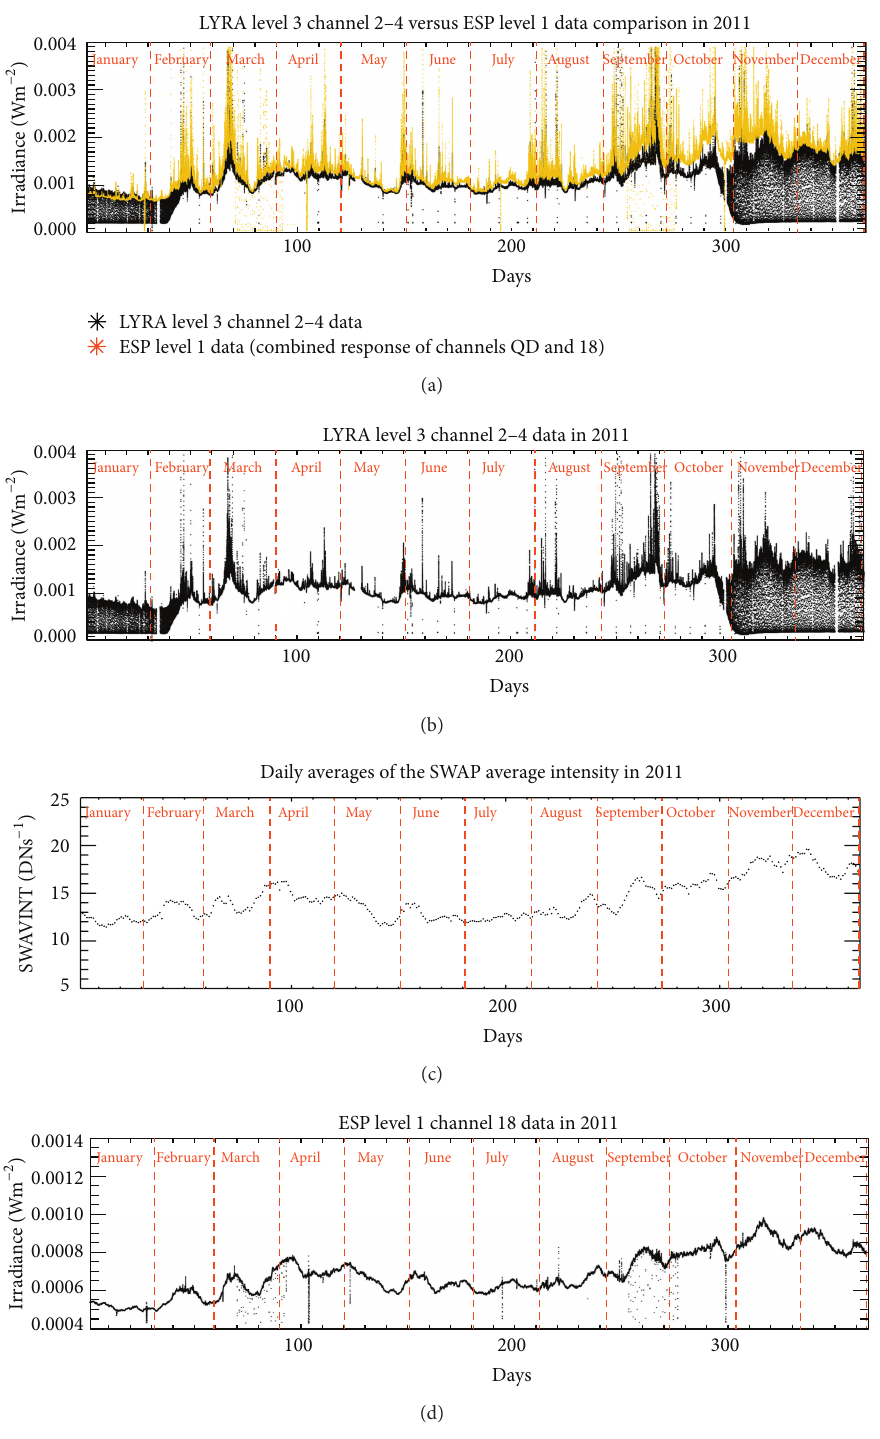
Figure 2: From top to bottom: LYRA level 3 channel 2–4 and ESP level 1 data (at combined responses of the channels QD and 18); LYRA channel 2–4 data alone; daily averages of SWAVINT data; and ESP channel 18 data variations in